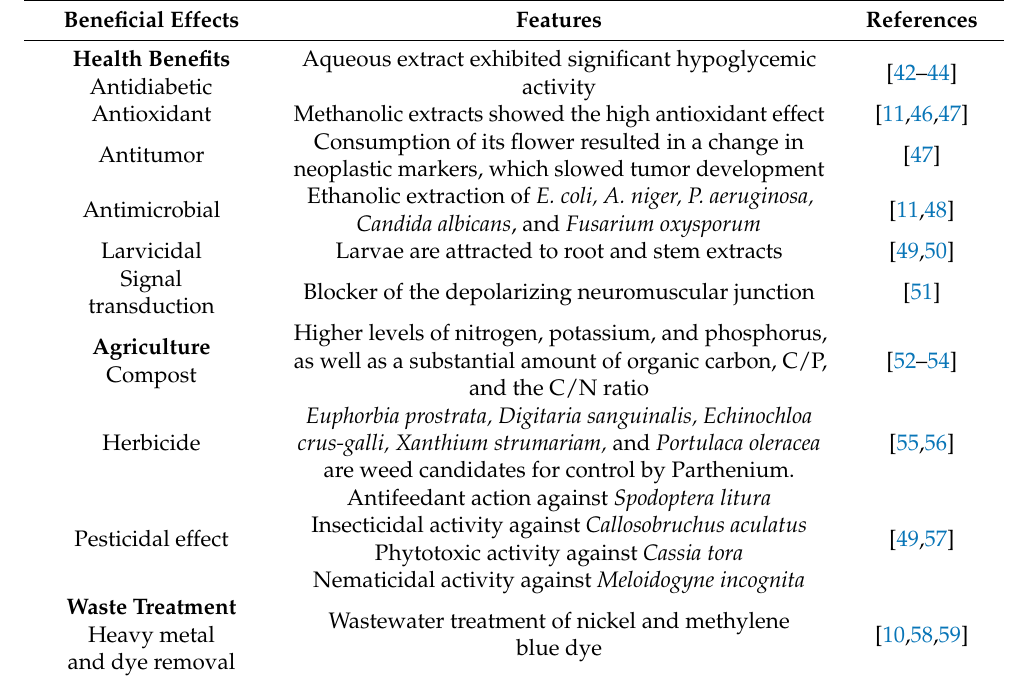
Table 1. Beneficial effects of Parthenium hysterophorus